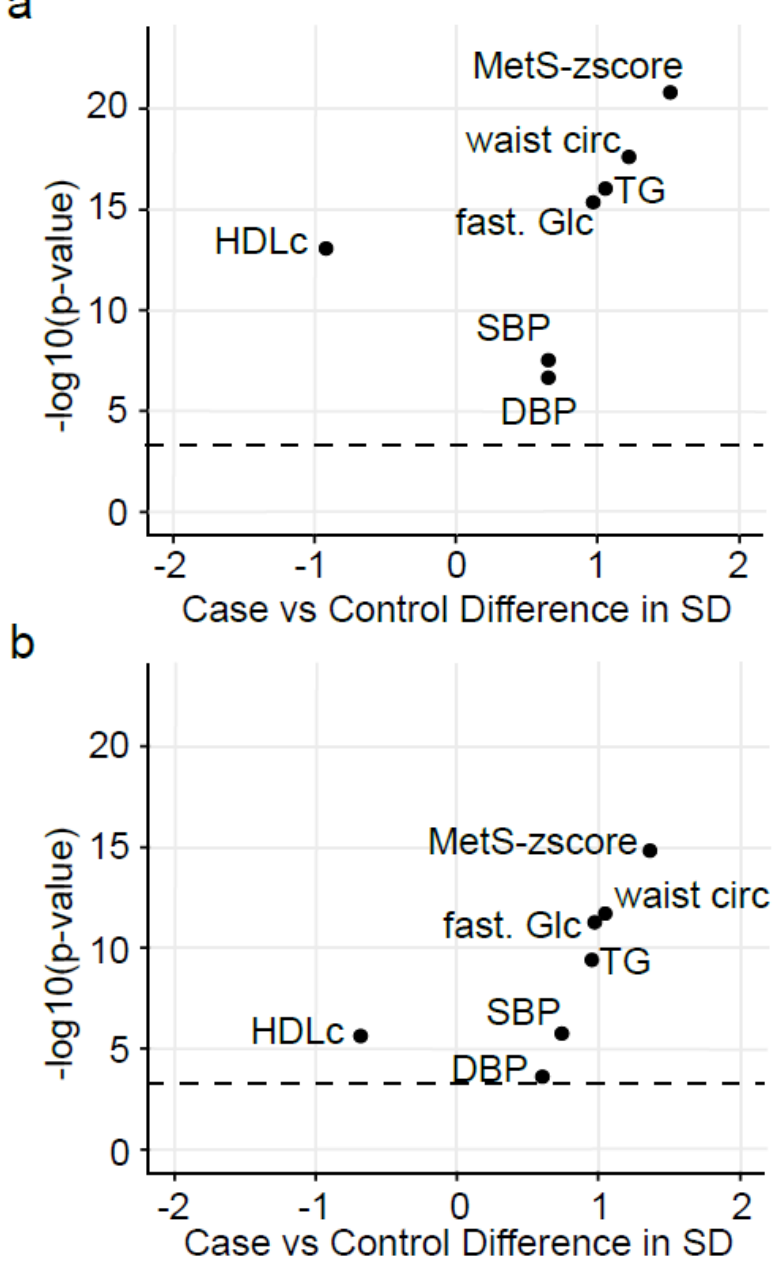
Figure 1. Baseline cardiometabolic differences between the Control and MetS participants in the Discovery and Replication studies. Volcano plots showing baseline differences of MetS status ( a ) between Case and Control participants in the Discovery study and ( b ) between Case and Control participants in the Replication study. Differences between Case and Control are expressed in standard deviation (SD) and were assessed using Wilcoxon signed-rank test followed by multiple tests correction (BH). Dashed line represents the significant threshold ( p -value BH = 0.0005). HDLc: high-density lipoprotein cholesterol, TG: triglycerides, fast. Glc: fasting glucose, waist circ: waist circumference, DBP and SBP: diastolic and systolic blood pressure.